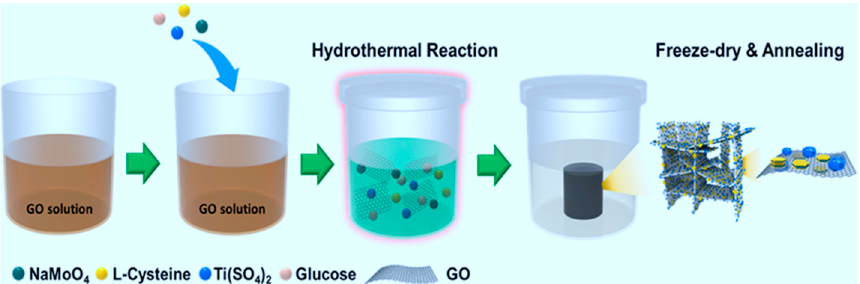
Figure 14. Schematization of one − pot solvothermal synthesis of TiO 2 − graphene − MoS 2 composite